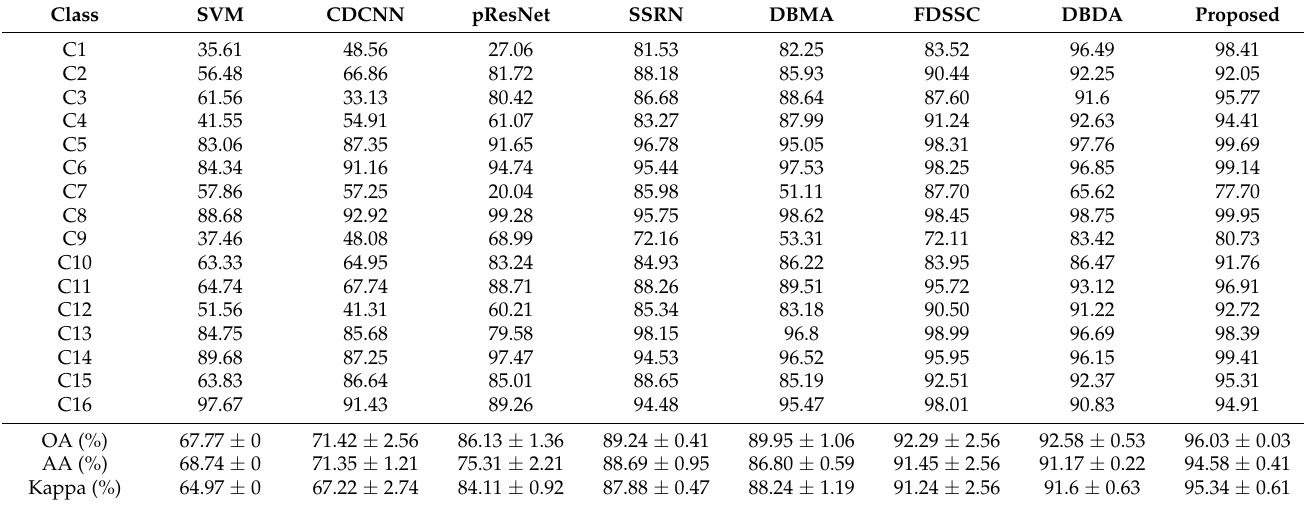
Table 6. KPI (OA, AA, Kappa) on Indian pines (IN) data set with 3% training samples.